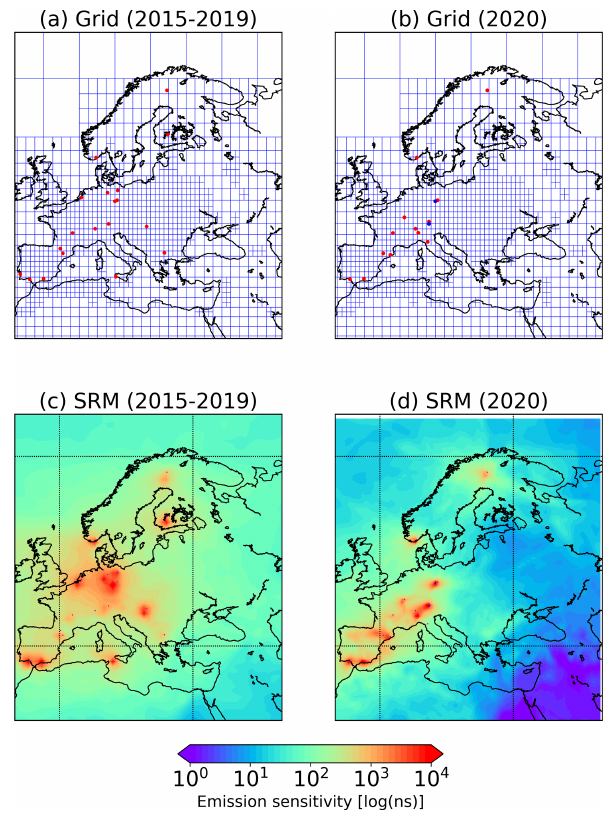
Figure 1. Aggregated inversion grid used for the (a) 2015–2019 and (b) 2020 inversions, respectively. The dependent measurements that were used in the inversion were taken from stations highlighted in red. The two independent stations that were used for the validation are shown in blue. (c, d) Footprint emission sensitivity (i.e. SRM) averaged over all observations and time steps for each of the inver- sions. Red points denote the location of each measurement